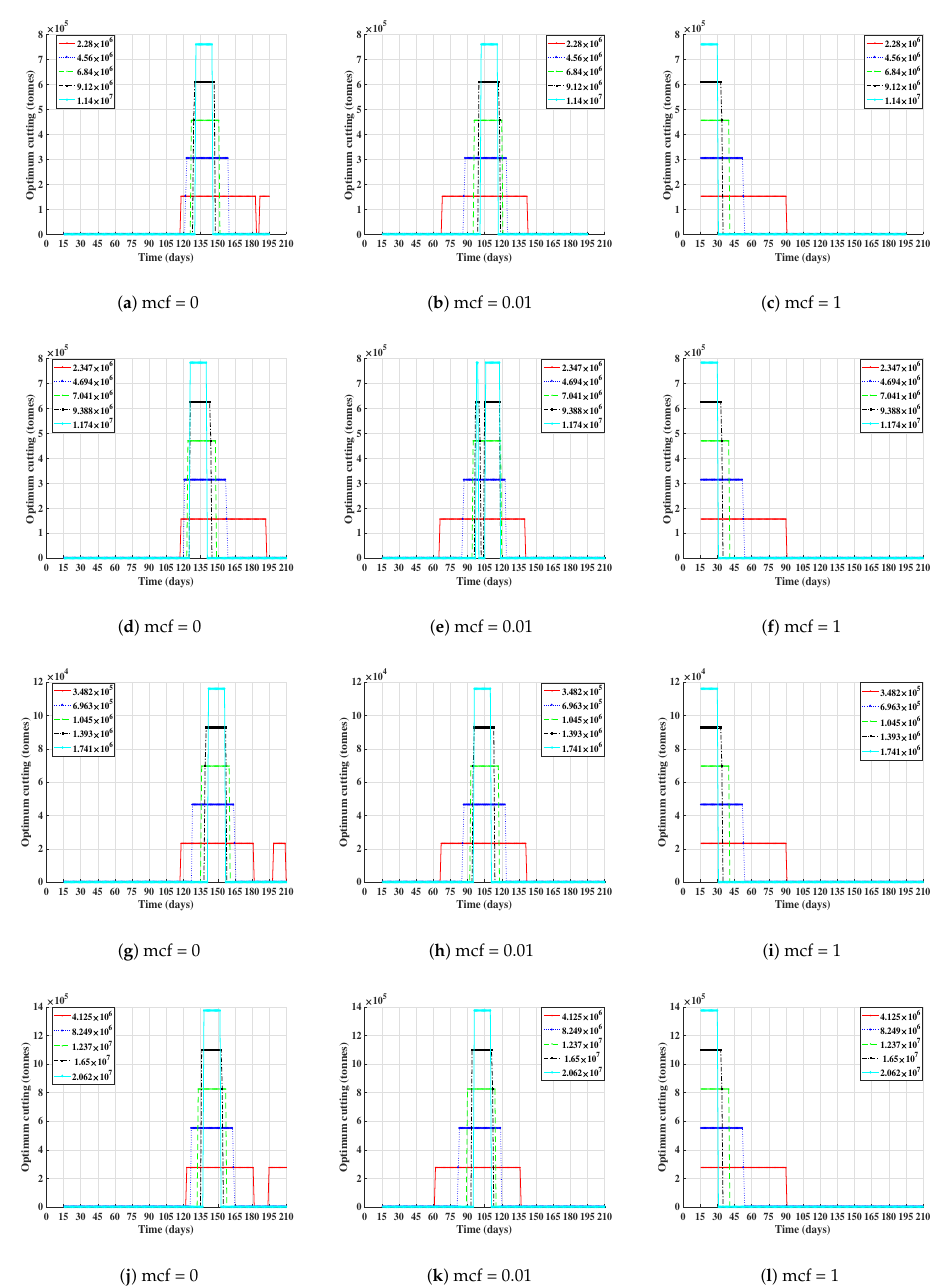
Figure 1. Optimum cutting of fresh sugarcane in four regions of Thailand in year 2017/18 showing effects of changing maintenance cost by fraction mcf of actual cost. North: ( a – c ), Central: ( d – f ), East: ( g – i ), North-east: ( j – l